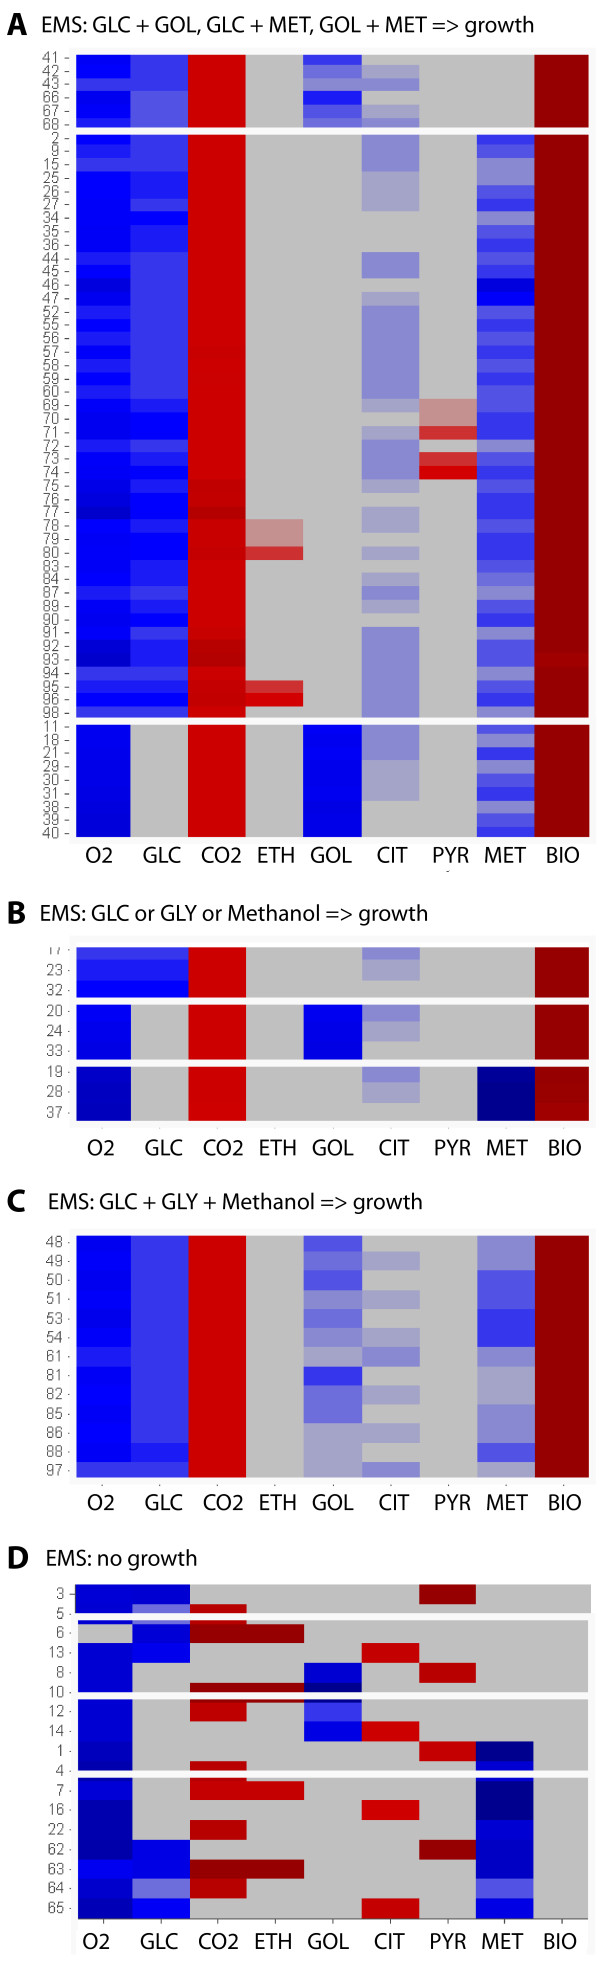
Elementary modes of the network of P. pastoris. Macroscopic equivalents of the corresponding elementary modes. Blue denotes substances being consumed by the EM, and red those being produced (the darker, the higher stoichiometric coefficient). Arrows highlighted those EMs with the maximum theoretical yield (in terms of growth) for each type.